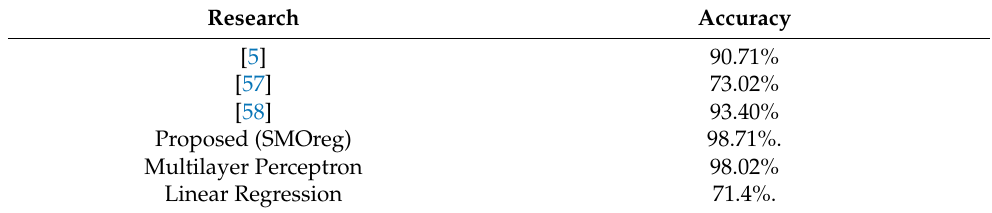
Table 9. Comparative